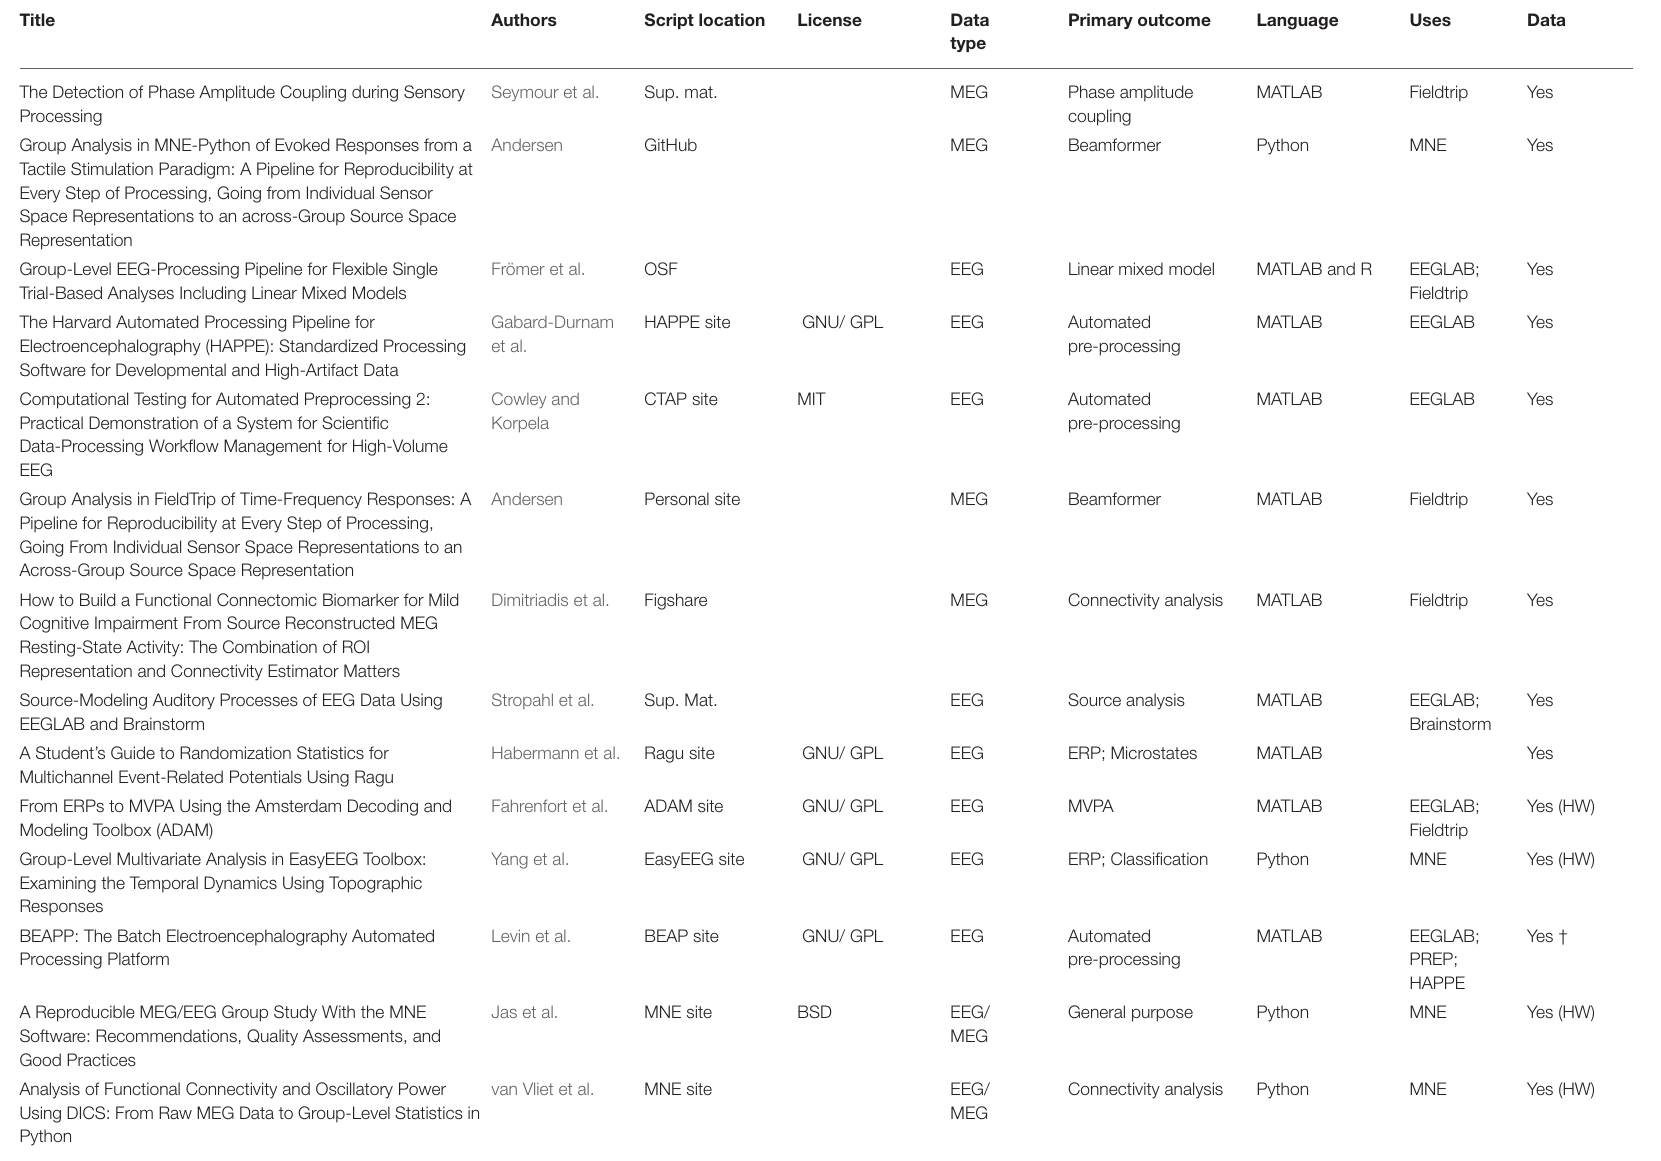
TABLE 1 | Article part of the special issue by order of publication